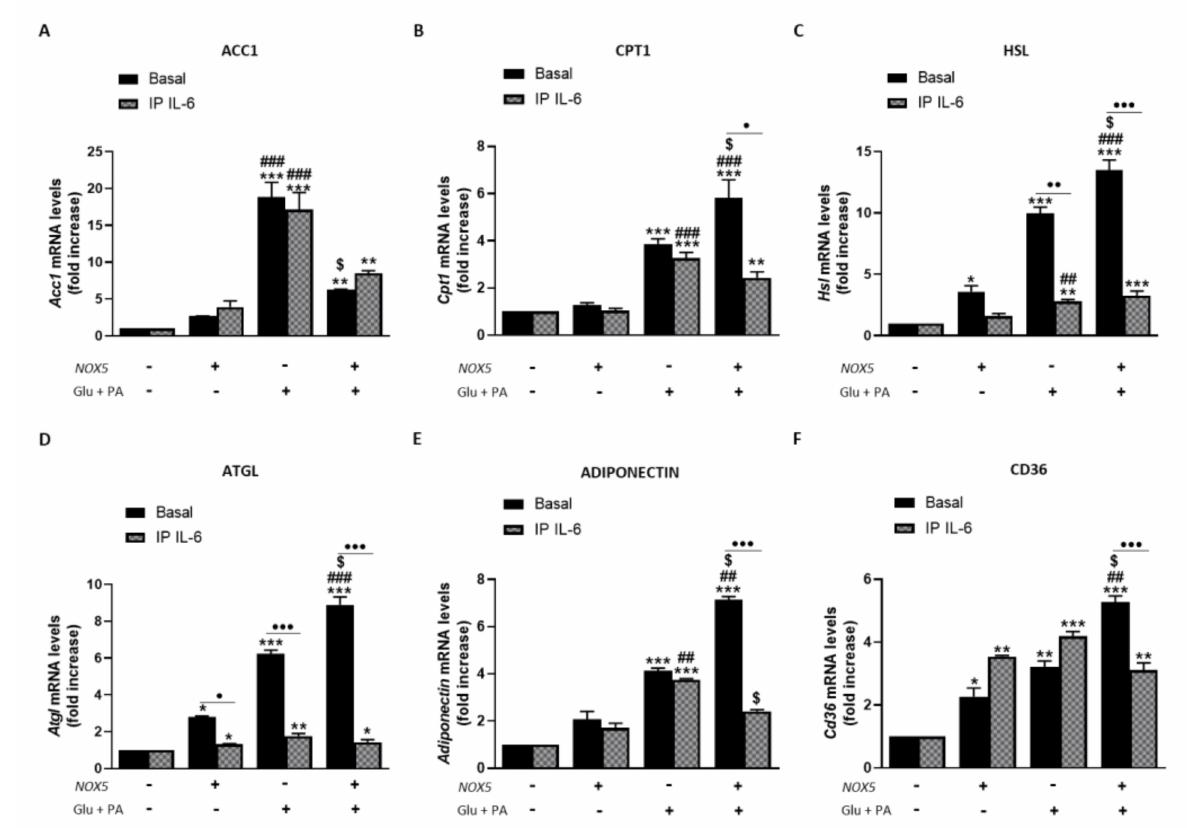
Figure 8. 3T3-L1 adipocytes showed increased lipolysis when cultured for 24 h with Glu + PA conditioned media from NOX5-expressing endothelial bEnd.3 cells. This increase is prevented when IL-6 is immunoprecipitated from Glu + PA conditioned media. ( A ) Acc1 mRNA levels in 3T3-L1 adipocytes. ( B ) Cpt1 mRNA levels in 3T3-L1 adipocytes. ( C ) Hsl mRNA levels in 3T3-L1 adipocytes. ( D ) Atgl mRNA levels in 3T3-L1 adipocytes. ( E ) Adiponectin mRNA levels in 3T3-L1 adipocytes. ( F ) Cd36 mRNA levels in 3T3-L1 adipocytes. mRNA levels are relative to Gapdh . Fold increase is relative to control group (Nox5( − )/Glu + PA( − )). Results are expressed as median plus confidence interval; * p < 0.05, ** p < 0.01, *** p < 0.001: differences relative to Nox5( − )/Glu + PA( − ); ## p < 0.01, ### p < 0.001: differences relative to Nox5(+)/Glu + PA( − ); $ p < 0.05: differences relative to Nox5( − )/Glu + PA(+); • p < 0.05, •• p < 0.01, ••• p < 0.001: differences relative to its basal counterpart. Statistical test used: aligned Rank